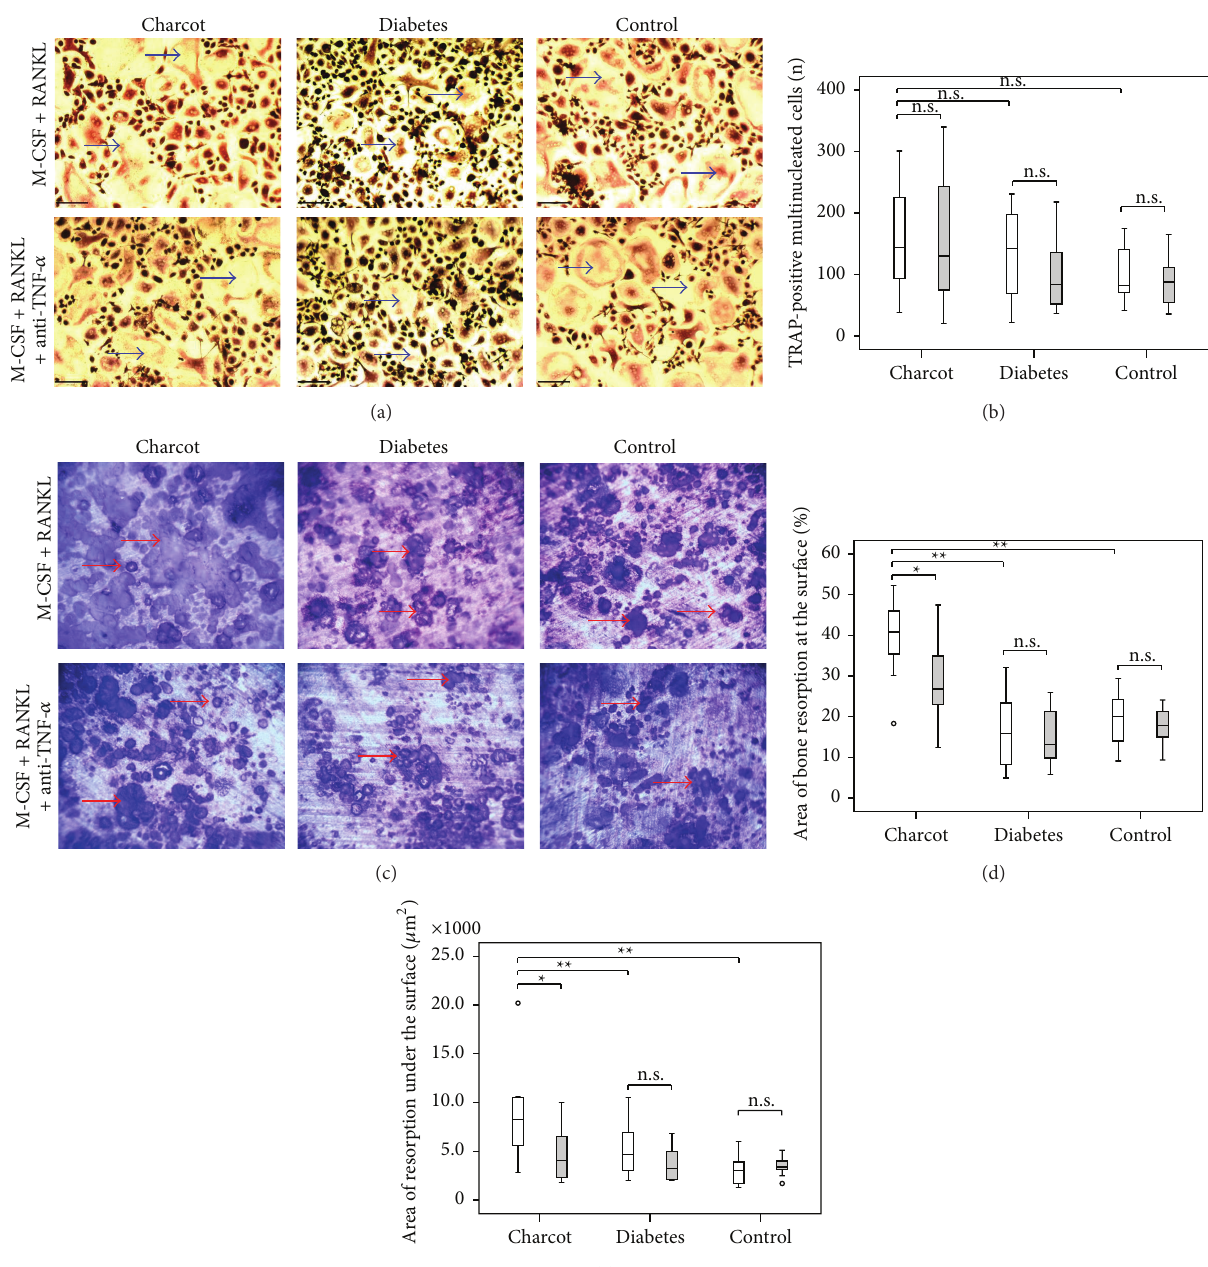
Figure 1: Osteoclast formation and resorption in Charcot patients, diabetic patients, and healthy control subjects in M-CSF + RANKL-treated cultures and in M-CSF + RANKL + anti-TNF- 𝛼 -treated cultures. Representative images of TRAP-positive multinucleated cells formed on plastic(Olympus;originalmagnification × 100,scalebar=200 𝜇 m)(a)andresorbedbovinebonediscs(OlympusBX60;originalmagnification × 200) (c). The arrows denote some of the TRAP-positive multinucleated cells (a) and some of the resorption pits (c). Comparison of the number of TRAP-positive multinucleated cells (b), the area of resorption at the surface (d), and the area of resorption under the surface (e) of resorbed bone discs between M-CSF + RANKL-treated cultures (white bars) and M-CSF + RANKL + anti-TNF- 𝛼 -treated cultures (grey bars). Significance assessed by Mann-Whitney 𝑈 test, levels of significance are demonstrated on the graphs; ∗ 𝑝 < 0.05 ; ∗∗ 𝑝 < 0.01 ; ns = nonsignificant ( 𝑝 > 0.05